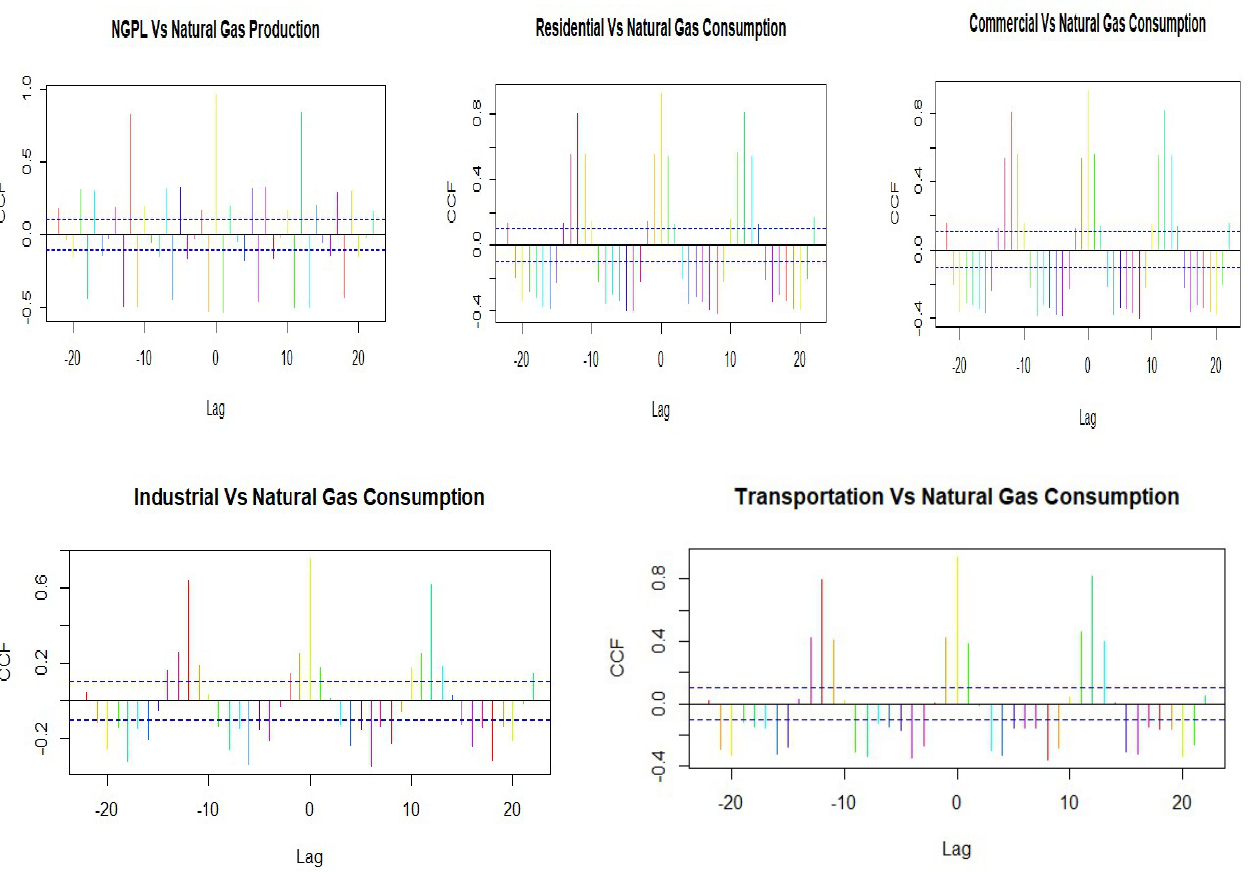
Figure 4. Cross-correlation function with exogenous variables. Table 5. Final parameter estimates for the SARIMAX (SARIMA with exogenous variables) model in natural gas production and consumption.